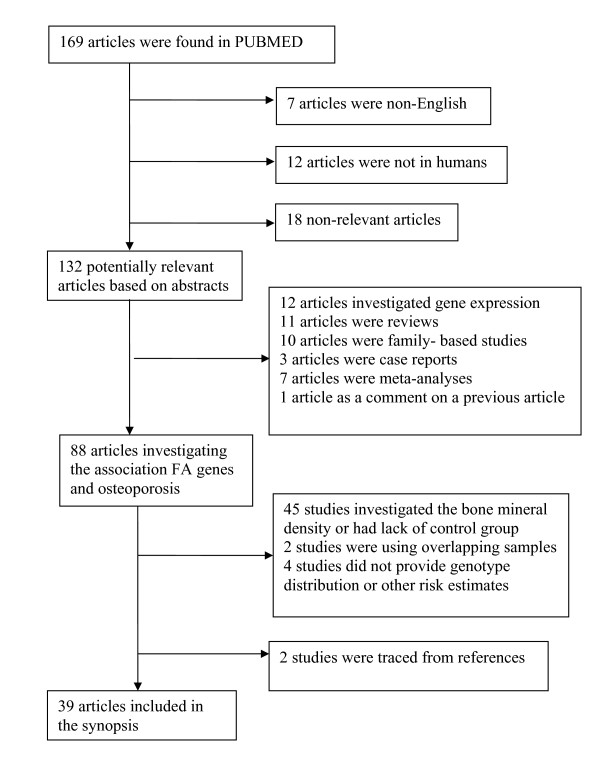
Flowchart of retrieved studies and studies excluded, with specification of reasons.